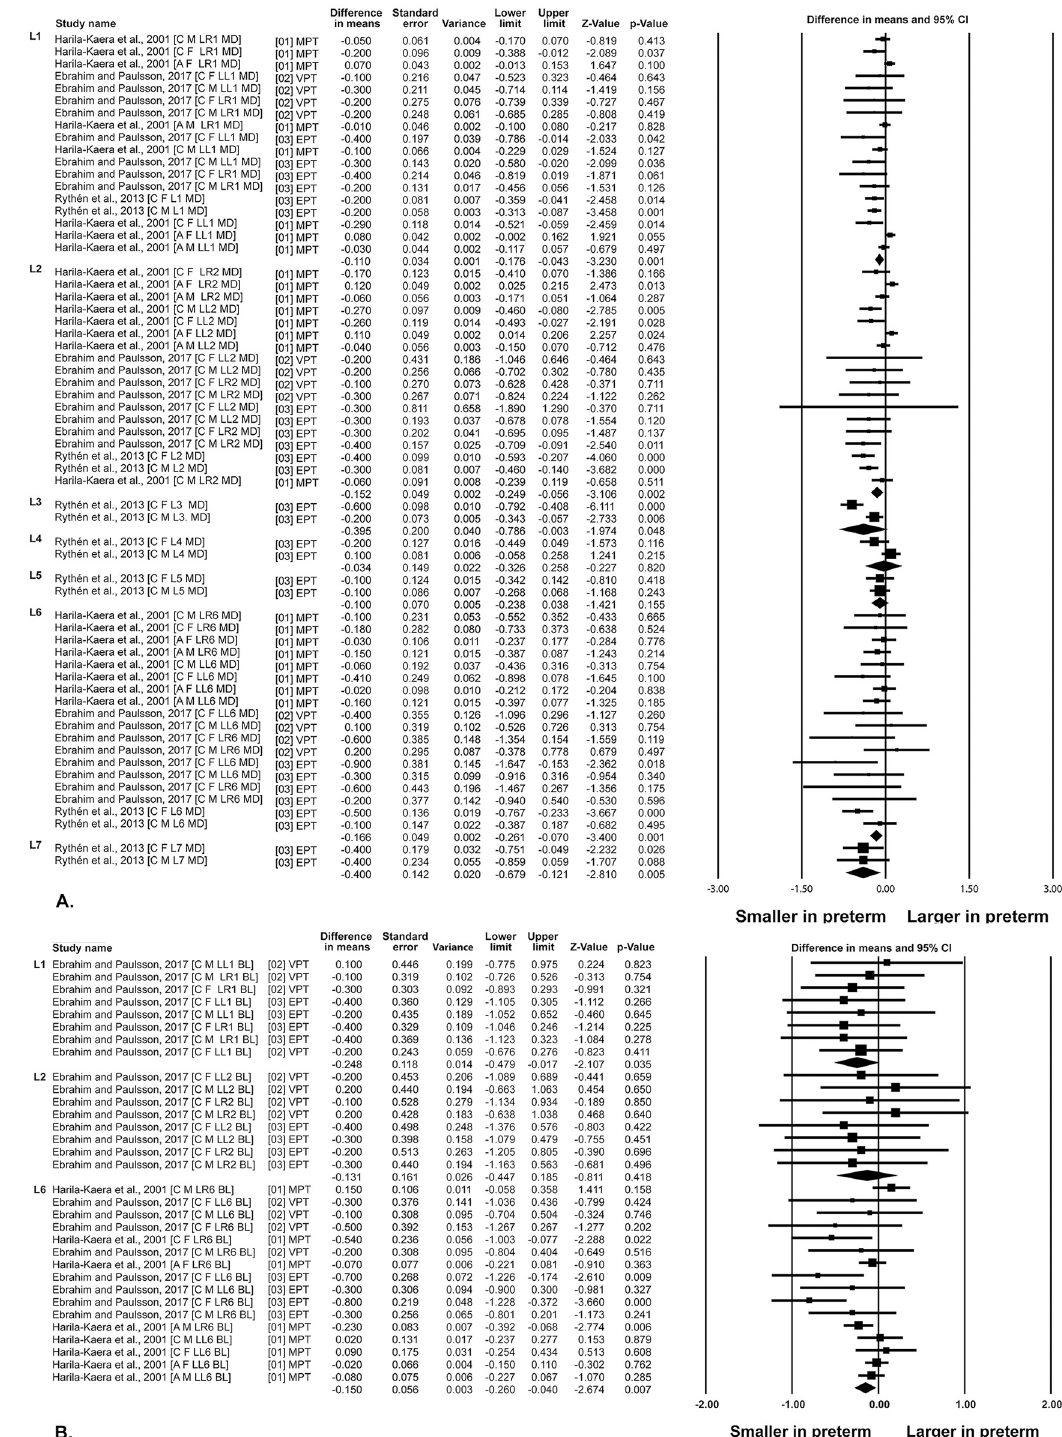
Fig 4. Differences in teeth dimension between preterm and control children. Mandibular teeth. A. Mesiodistal dimensions. B. Buccolingual dimensions. A: African American; BL: Buccolingual; C: Caucausian; CI: Confidence Interval; EPT; Extremely preterm; F: Females; LL: Mandibular left teeth; LL: Mandibular right teeth;M: Males; MD: Mesiodistal; MPT: Moderate preterm; VPT: Very preterm.